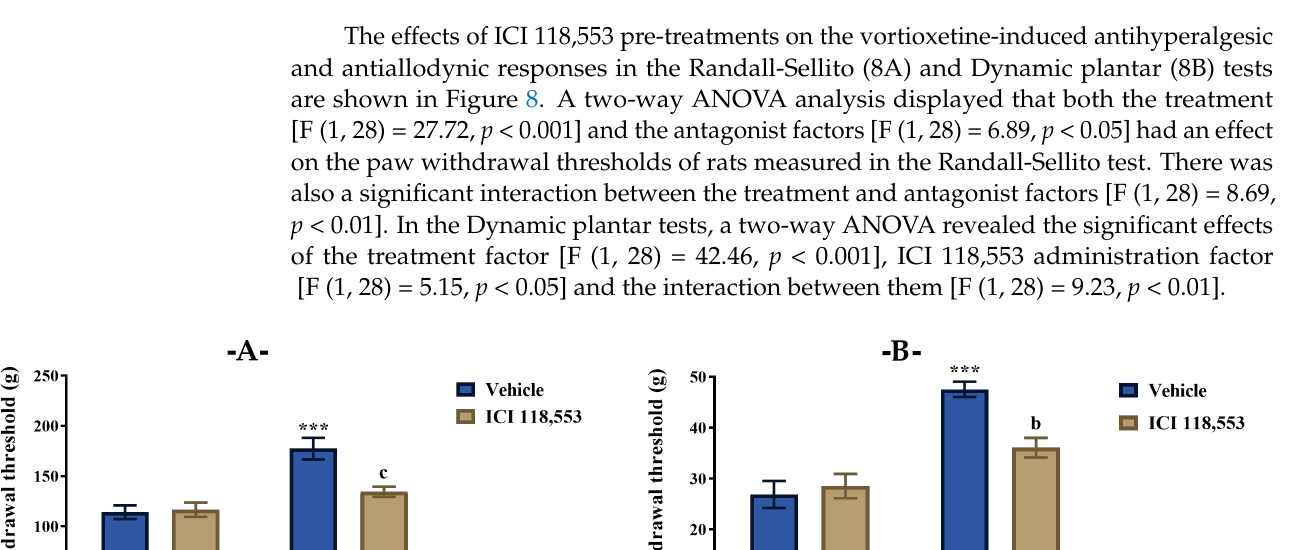
Figure 8. The effects of ICI 118,553 pre -treatment on antihyperalgesic ( A ) and antiallodynic ( B ) responses induced by the administration of 5 mg/kg vortioxetine in the Randall– Selitto and Dy- namic plantar tests, respectively. Values are given as mean ± S.E.M. Significant difference against vehicle-administered diabetic g roup (DM) *** p < 0.001; s ignificant difference against vortioxetine - administer ed diabetic group (DM+Vort 5) b p < 0.01; c p < 0.001. Two -way ANOVA, post hoc Bon- ferroni multiple comparison test, n = 8.